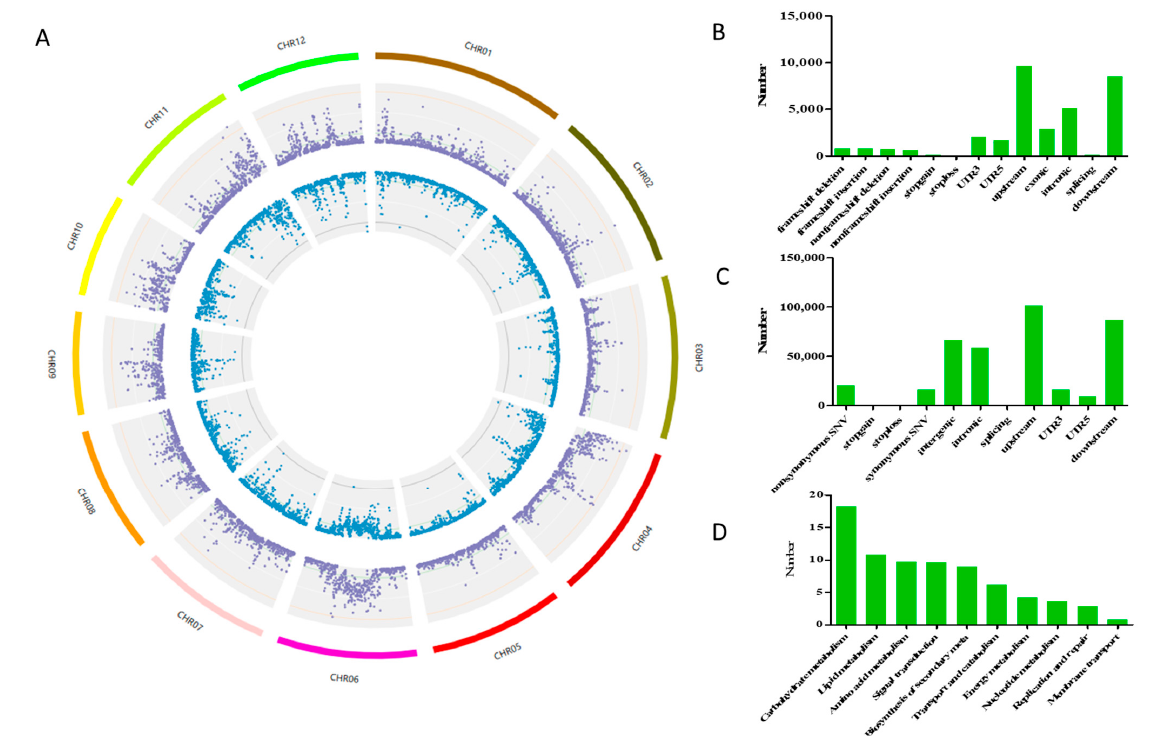
Figure 4. Genome-level variation of YSD compared to ZH11. Fresh leaves of 10-day-old plants were sampled for isolation of genomic DNA (gDNA) to perform whole-genome resequencing. ( A ) Genome variation Circos diagram. Circle 1: The chromosome; Circle 2: The purple locus represents the distribution of SNP density in the genome; Circle 3: Blue sites represent fractions of genomic InDel density. ( B ) Statistical map of SNP annotation results at gene level. ( C ) Map of InDel annotation results at gene level, and ( D ) pathway analysis of mutated gene loci. Table 1. Cell-wall-associated variation in gene annotation.